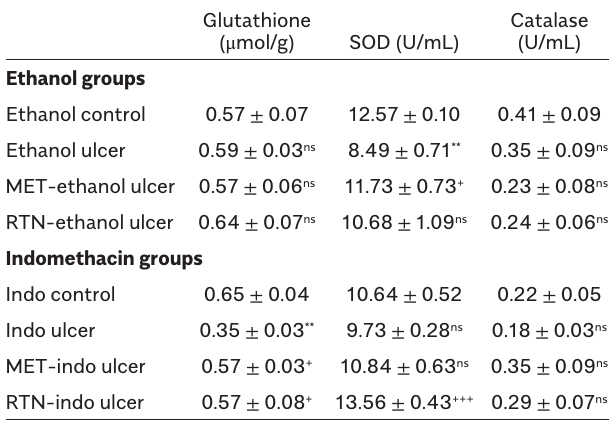
Table 2. Gastric Glutathione Content, SOD, and Catalase Enzyme Activities in Experimental Groups